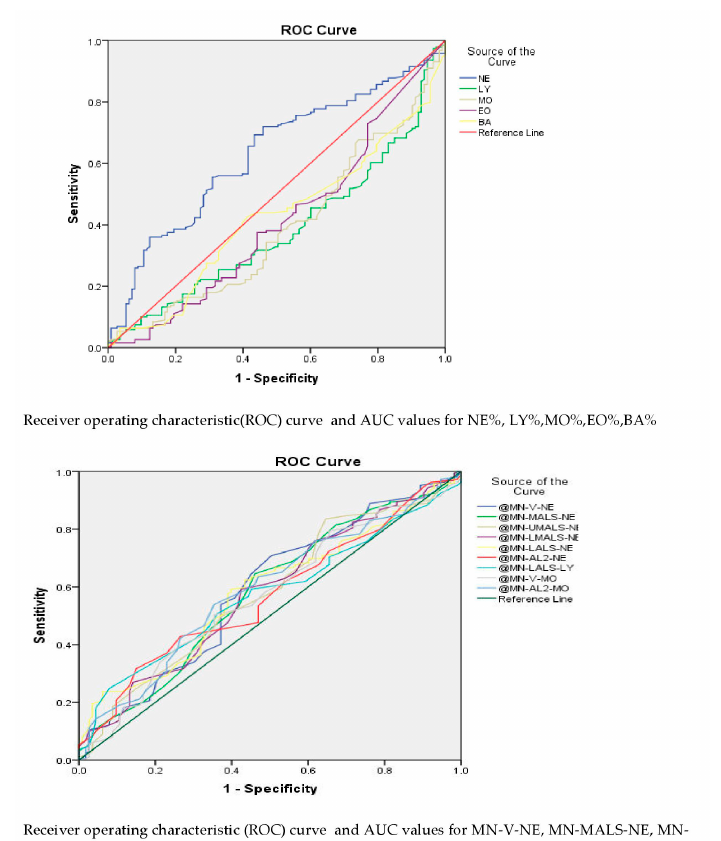
Figure 2. ROC curve for COVID-19 against non-COVID-19 Influenza-like illnesses.